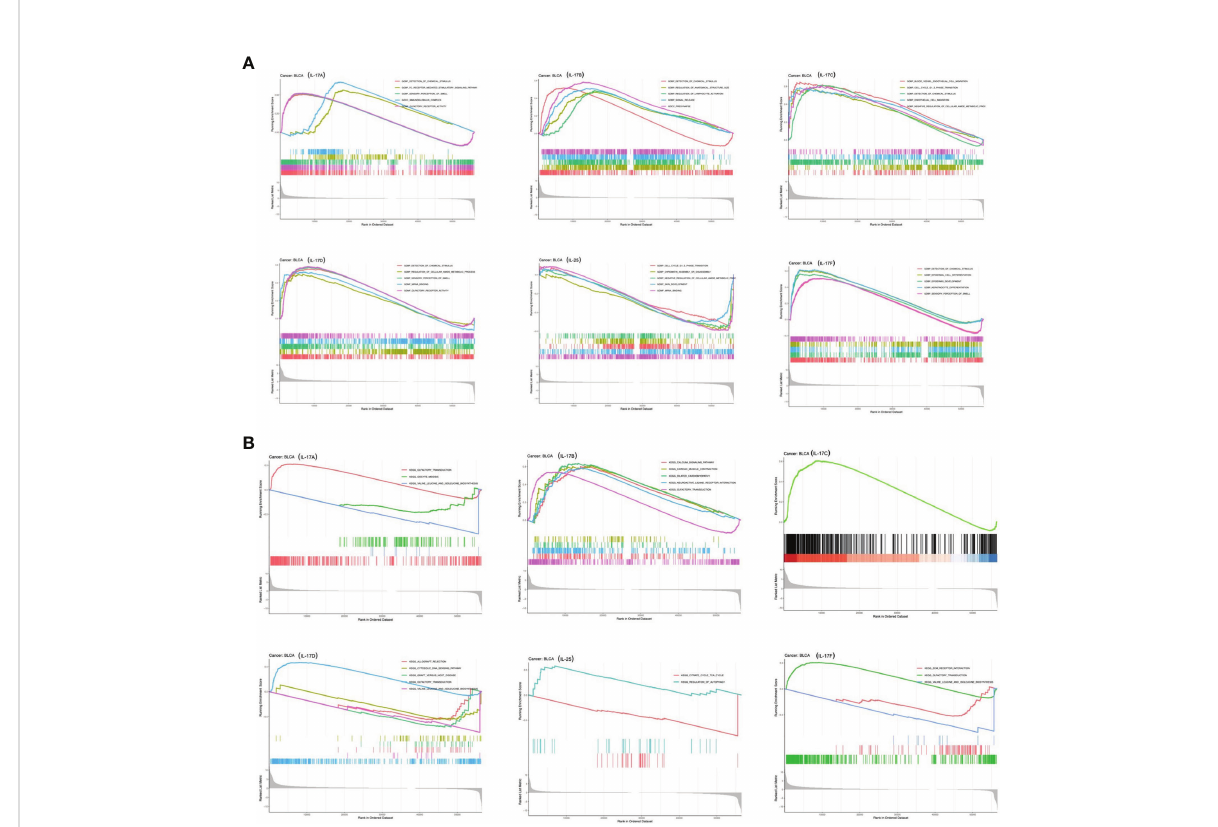
FIGURE 8 GSEA based on GO (A) and KEGG (B) databases between the IL-17A – F low-expression group and high-expression group in